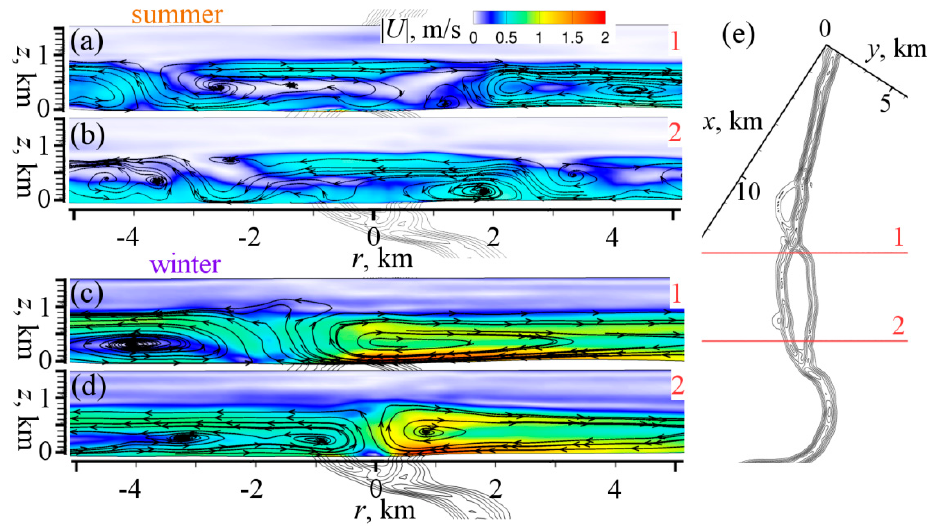
Figure 5. Streamlines and contours of the velocity magnitude in vertical cross-sections, averaged over one day of simulation. ( a , b ) Winter case; ( c , d ) Summer case; ( e ) The cross-sections positions.